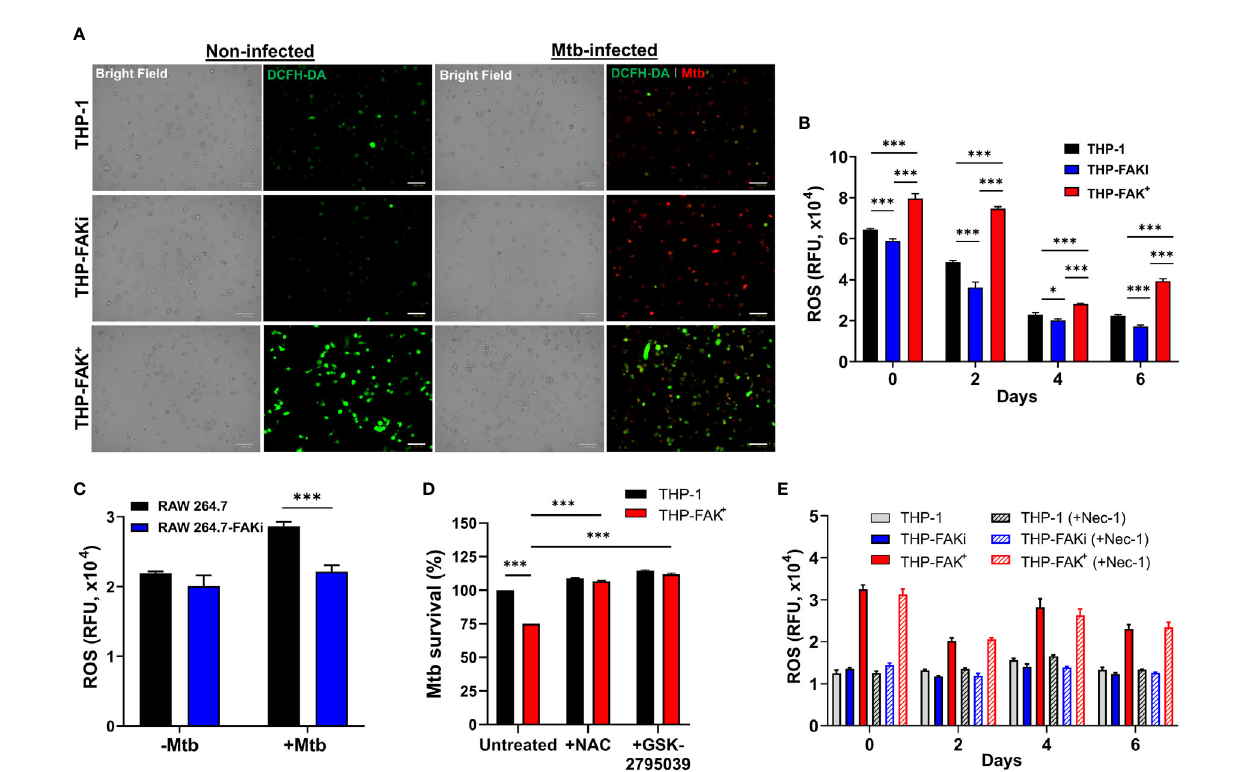
FIGURE 7 | Expression of FAK induces production of ROS to control Mtb infection. (A) THP-1, THP-FAKi, and THP-FAK + macrophages were infected with Mtb- tdTomato (red signal) for 6 days, after which cells were stained with DCFH-DA (5 m M, green signal) for 30 minutes at 37°C. Representative Bright Field and fl uorescence images of uninfected and Mtb-infected (red) macrophages (green, ROS), are shown using a 20x objective. Scale bar, 100 m m. (B) THP-1 macrophages were infected and stained with DCFH-DA as in (A) and the amount of ROS production was quanti fi ed at the indicated time points post-infection using a fl uorescence plate reader at 485 nm/535 nm. (C) RAW 264.7 macrophages were infected and stained as in (A) and the amount of ROS production was quanti fi ed at day 6 post- infection. (D) THP-1 and THP-FAK + macrophage were pre-treated with 10 mM N-acetyl-cysteine (NAC) or 25 µM GSK2795039 for 24 h and then infected with Mtb- luciferase at an MOI of 10. Infected macrophages were lysed at day 6 post-infection and the resultant luminescence signal was measured as a proxy for the relative number of viable of Mtb. RLU signals were normalised to mock treated THP-1 cells as 100% and depicted as % Mtb survival. (E) THP-1, THP-FAKi, and THP-FAK + macrophages were mock treated or pre-treated with 30 µM necrostatin-1 for 24 h, after which cells were infected with Mtb at MOI of 10. At indicated time points post-infection, infected macrophages were stained with DCFH-DA as in (A) and fl uorescence signals for ROS production was measured. Error bars represent the mean ± SD of three independent biological replicates. * p < 0.05, *** p <